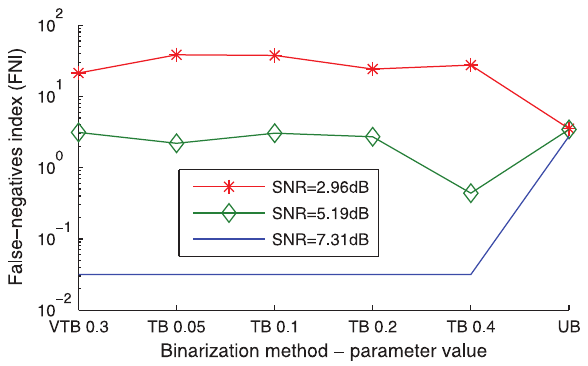
Figure 4. False-negatives index ( FNI ). False-negatives index ( FNI ) is plotted in log scale versus a subset of binarization configurations for three representative synthetic datasets out of 60. It should be noted that the binarization configurations are not entirely ordered according to their tightness.